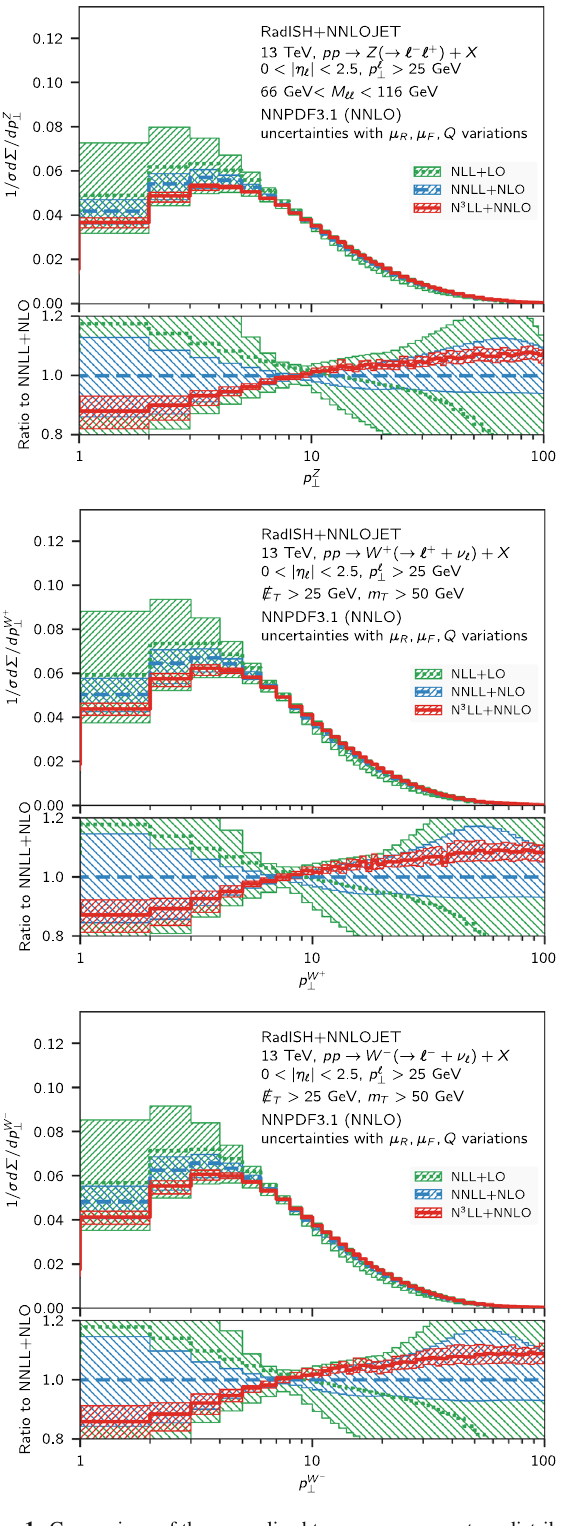
Fig. 1 Comparison of the normalised transverse momentum distribu- tion for neutral and charged Drell–Yan pair production at NLL+LO (green, dotted), NNLL + NLO (blue, dashed) and N 3 LL + NNLO (red, √ s = 13 TeV for the fiducial volume defined in the text. The solid) at lower panel shows the ratio to the NNLL + NLO result